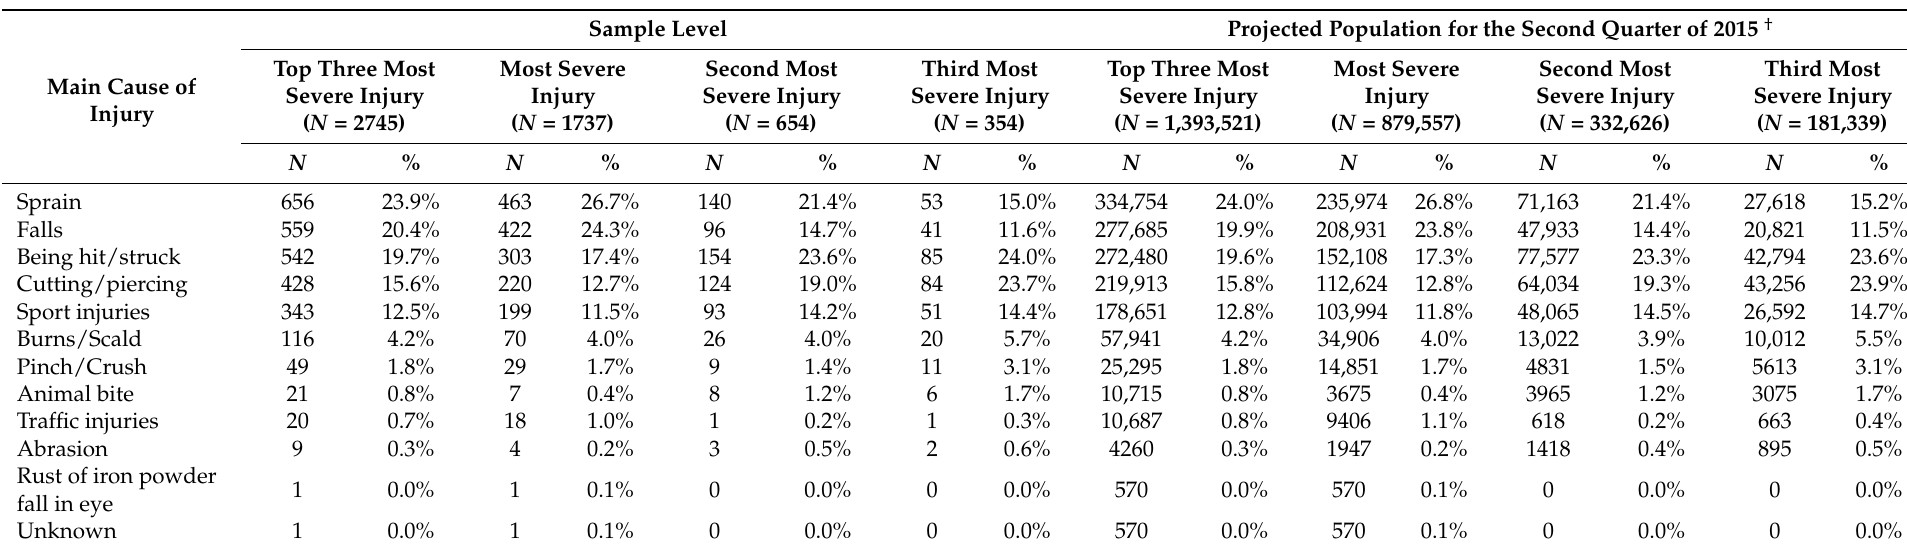
Table 2. The main causes of the top three most severe unintentional injuries over the previous 12 months.